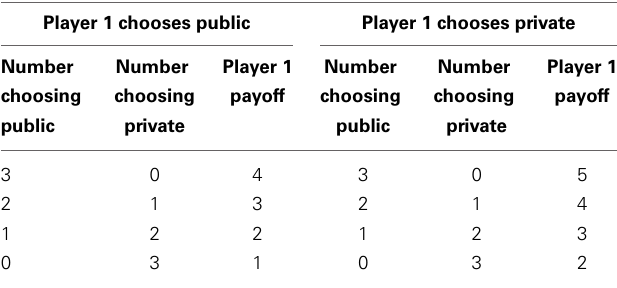
Table 1 | Overview of the possible payoffs for a single